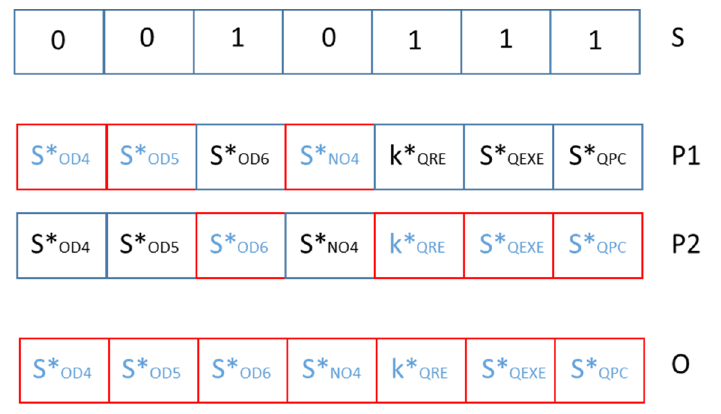
Figure A2. Crossover operation.